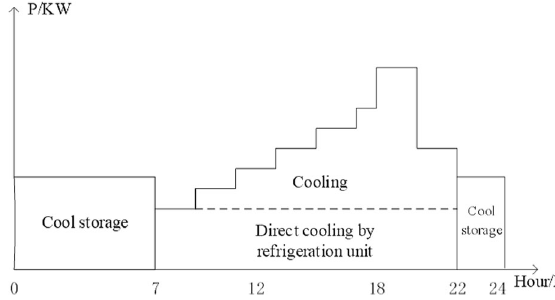
Fig. 3 Partial operating mode. The air conditioning system stores a certain amount of cold energy in